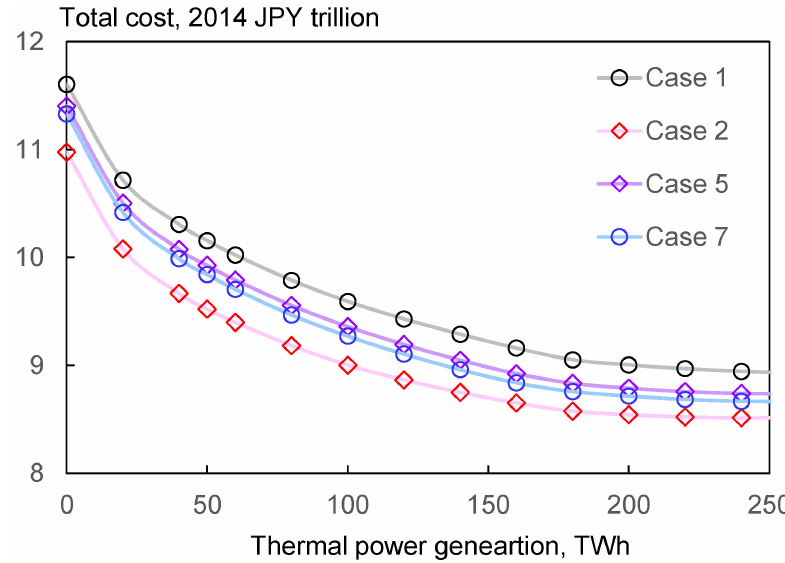
Figure 8. Total cost for Cases 1, 2, 5, and